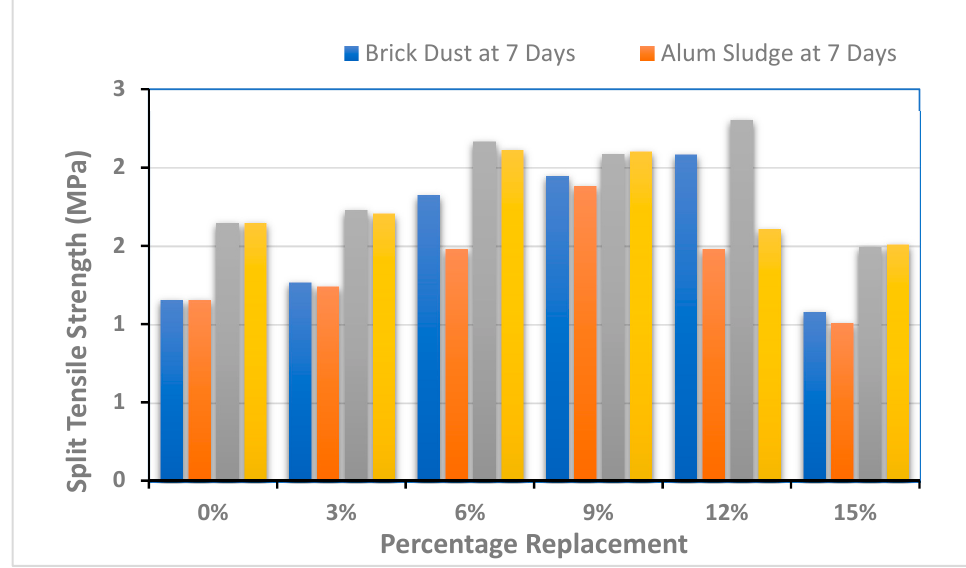
Figure 6. Split tensile strength performance of composite material.